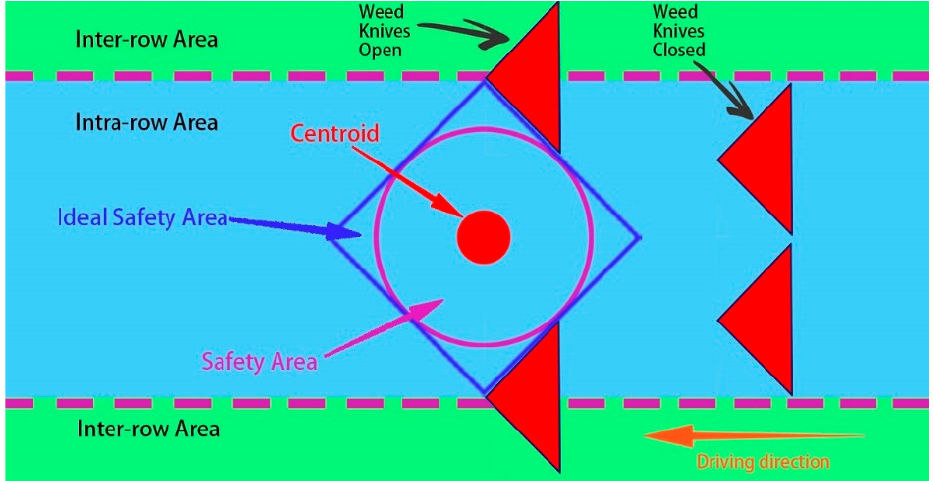
Figure 8. The working process of the weeding knives: on the right side of the figure, the weed knives were placed in the closed position where they are close to each other, and they can kill all weeds in the intra-row area. In the center of this figure, the weed knives were placed in the open position in order to bypass the lettuce plant.